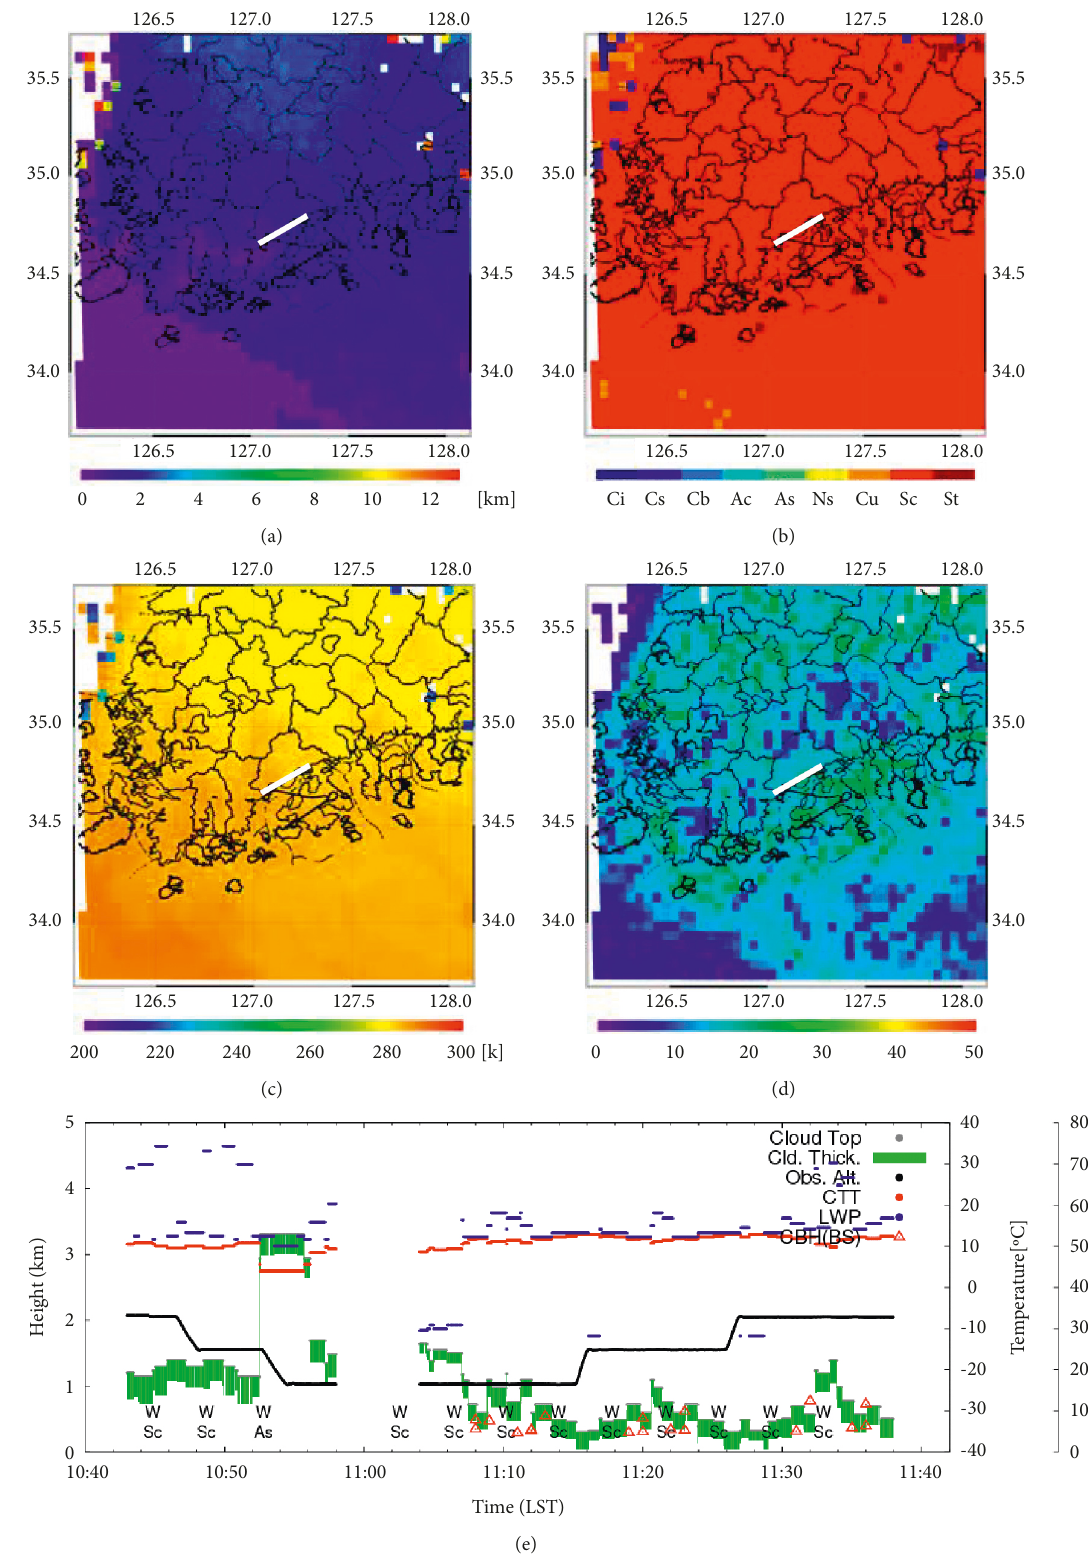
Figure 5: Horizontal distribution of (a) cloud top height, (b) cloud type, (c) cloud top temperature, (d) cloud optical depth at 1030 LST, and (e) time series of cloud top height (grey), cloud thickness (green), observed height by aircraft (black), cloud top temperature (red), liquid water path (blue), cloud base height (red triangle), and cloud type (character) on April 25,